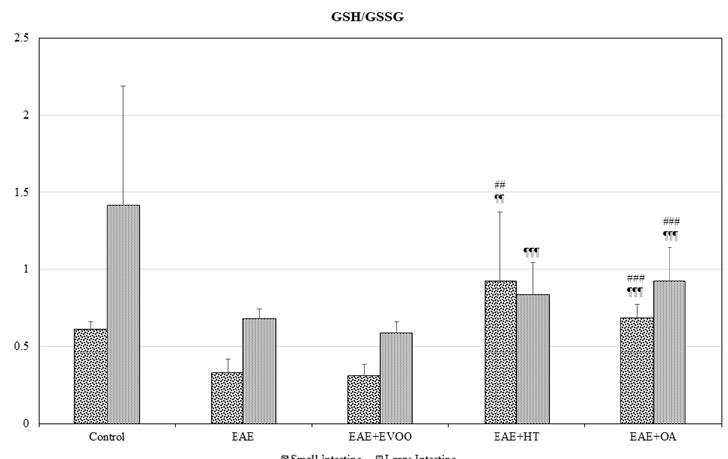
Figure 2. GSH/GSSG ratio in small and large intestine: reduced glutathione/oxidized glutathione ratio in the following study groups: control group (not manipulated); EAE group (experimental autoimmune encephalomyelitis induced by myelin oligodendrocyte glycoprotein (MOG)); EAE + extra-virgin olive oil (EVOO); EAE + hydroxytirosol group (HT); and EAE + oleic acid group (OA). ## p < 0.01 vs. EAE; ### p < 0.001 vs. EAE; ¶¶ p < 0.01 vs. EAE + EVOO; ¶¶¶ p < 0.001 vs. EAE + EVOO.